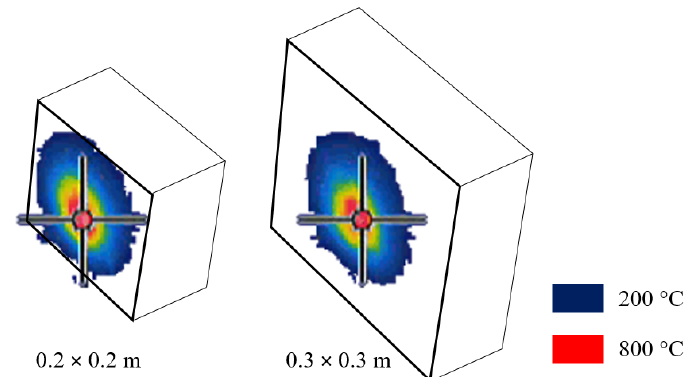
Figure 3. The directly fire-affected zones for the tested concrete element.